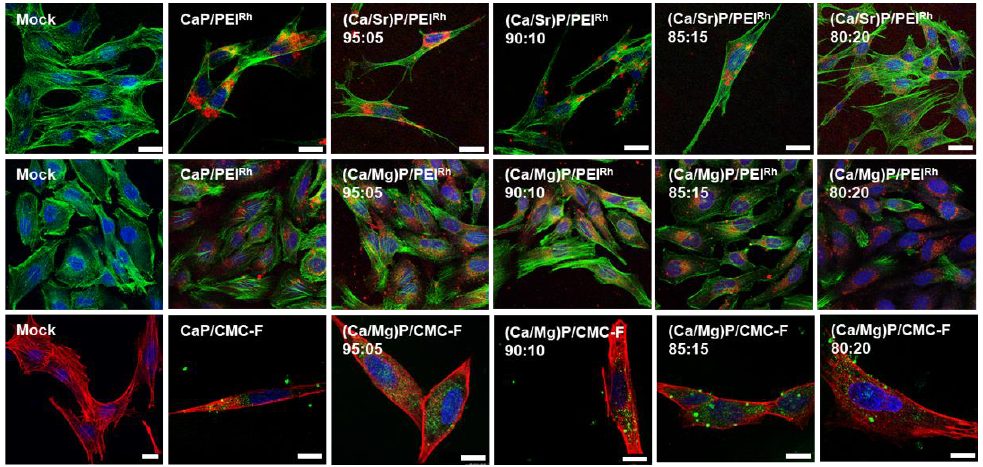
Figure 9. Confocal laser scanning microscopy of MC3T3 cells after incubation with nanoparticles for 24 h. Top row: Undoped calcium phosphate and strontium-doped calcium phosphate nanoparticles labelled with PEI Rh . Blue: Cell nucleus (Hoechst33342); green: Cytoskeleton (actin with AlexaFluor ® -488 phalloidin); red: PEI Rh -labelled nanoparticles. Middle row: Calcium phosphate and magnesium-doped nanoparticles labelled with PEI Rh . Blue: Cell nucleus (Hoechst33342); green: Cytoskeleton (actin with AlexaFluor ® -488 phalloidin); red: PEI Rh -labelled nanoparticles. Bottom row: Calcium phosphate and magnesium-doped nanoparticles labelled with CMC-F. Blue: Cell nucleus (Hoechst33342); red: Cytoskeleton (actin with AlexaFluor ® -647 phalloidin); green: CMC-F-labelled nanoparticles. Control: Untreated cells (Mock). Scale bars: 20 µm.